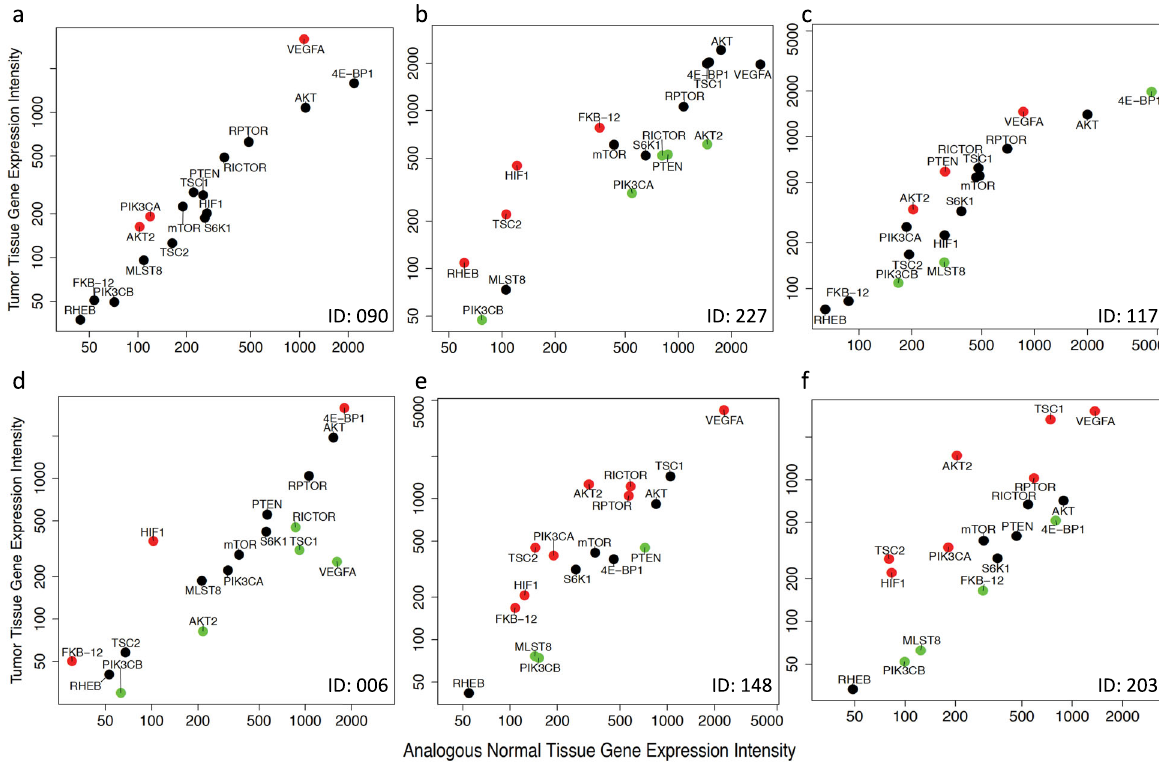
Fig. 1 DDPP intensity plots pro fi les for patients treated with everolimus. DDPP tumor/normal intensity plots pro fi les of differential gene expression of the everolimus key genes for the six patients treated with everolimus in monotherapy. Clinical outcome is described in Table 1. a ID 090, head and neck carcinoma, PFS = 1.3 months (progressive disease), third therapy line. b ID 227, liposarcoma, PFS = 1.7 months (progressive disease) in fi fth therapy line. c ID 117, head and neck carcinoma, PFS = 1.9 months (progressive disease), third therapy line. d ID 006, unknown primary origin, PFS = 8.1 months (stable disease) in second therapy line. e ID 148, neuroendocrine tumor of small gut PFS = 11.6 months (stable disease) in third therapy line. f ID 203, neuroendocrine tumor of small intestine, PFS = 60 + months (partial response disease) in second therapy line. Y axis: intensity of the expression in tumors, X axis: intensity of the expression in normal matched tissue. Intensities are measured as relative fl uorescence unit (RFU) signal as assessed with Agilent microarray technology. Overexpression for a